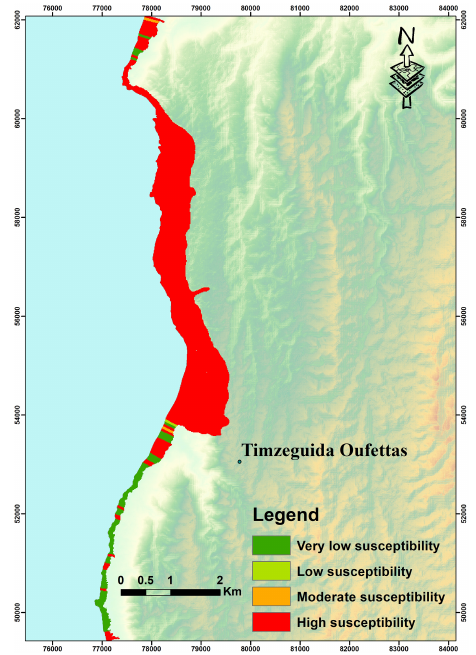
Figure 10. Landslide susceptibility map using the ETU method for Model 1.